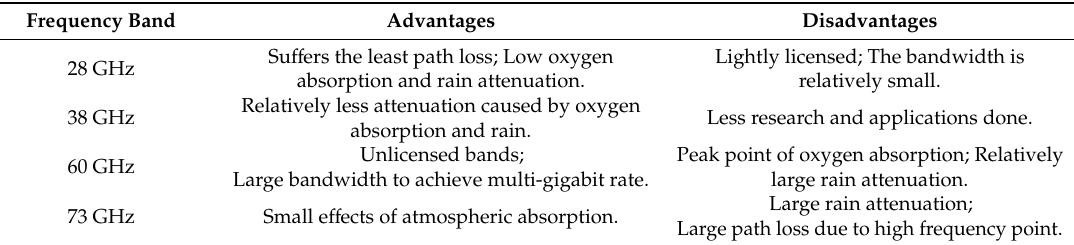
Table 1. Millimeter wave band for 5G communications.